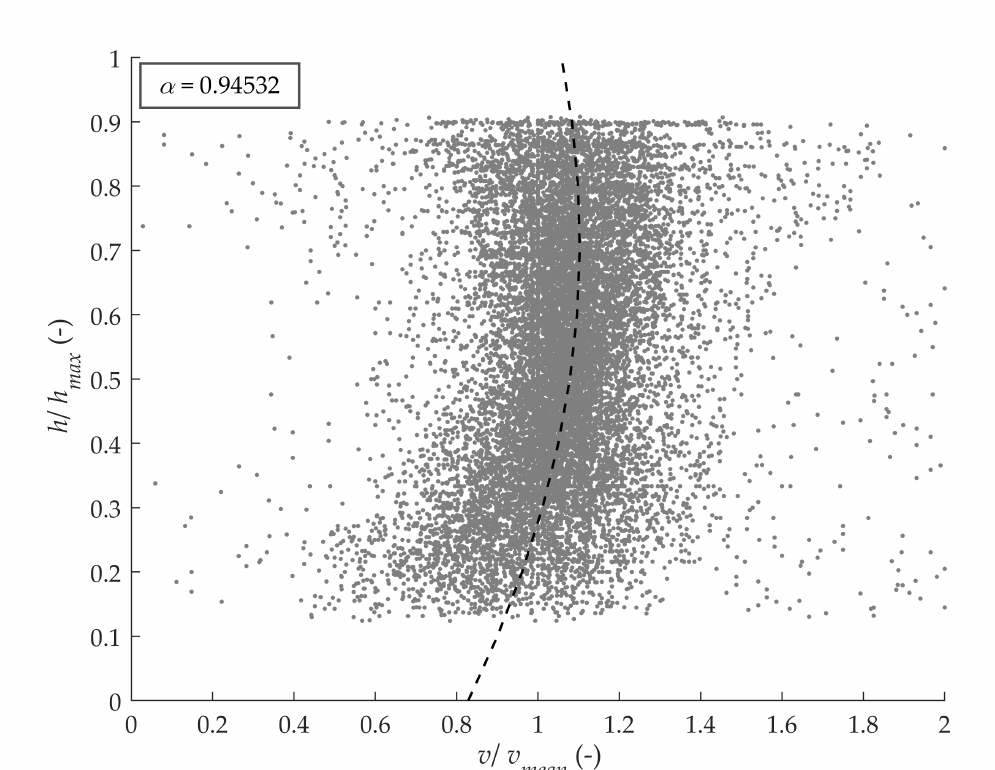
Figure 5. ADCP relative velocity magnitude data. Characteristic velocity profile obtained using second-degree polynomial fit. The alpha value represents the ratio between the extrapolated surface velocity and the depth-averaged velocity.